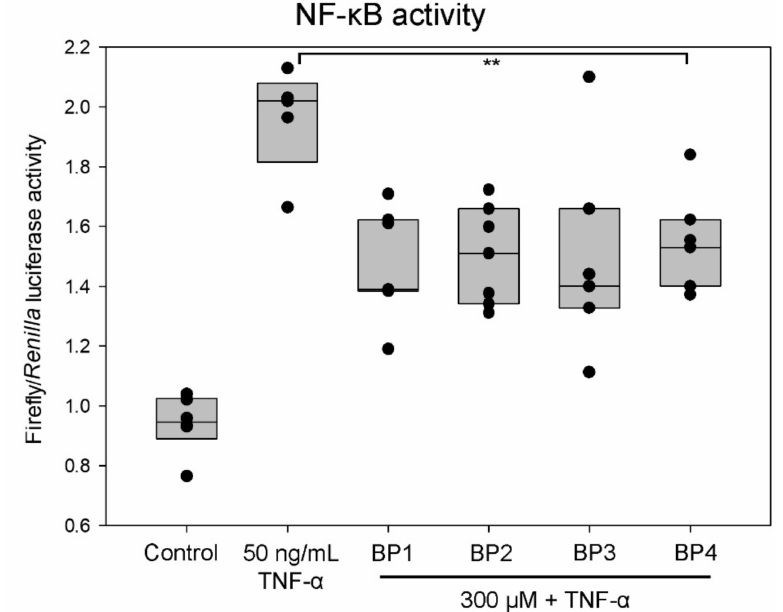
Figure 3. Activation of NF- κ B after treatment with 50 ng / mL TNF- α and 300 µ M synthetic peptides. Ea.hy926 cells were transfected with NF- κ B:Luc together with the pRL-CMV (10:1) reporter vectors. The normalized luciferase activity (firefly / Renilla) was measured using the Dual-Luciferase Reporter Assay in extracts from control, TNF- α , and synthetic peptide-treated cells. Upper and lower bars of box plots represent the 25th and 75th percentiles, respectively. Median is represented as the bar inside the box plot. The data shown represent values of three independent experiments (dots). The asterisks ** indicate statistically significant di ff erences compared with stimulated cells ( p < 0.015). The BP treatment prevented TNF- α -induced proinflammatory NF-kB activation by